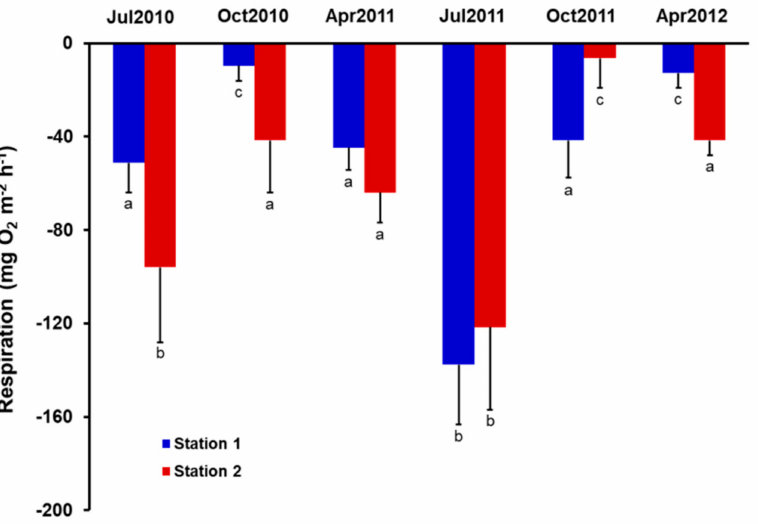
Figure 4. Ex situ respiratory oxygen consumption rates (given as mg O 2 m − 2 h − 1 ) over the course of the seasons at both stations S1 and S2. The data are given as the mean values with the standard deviation ( n = 3). Different letters reflect significantly different mean values (Tukey’s test, p <